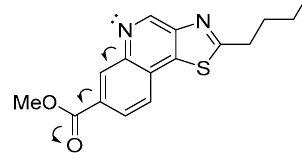
Figure 2. Deactivation of N5.